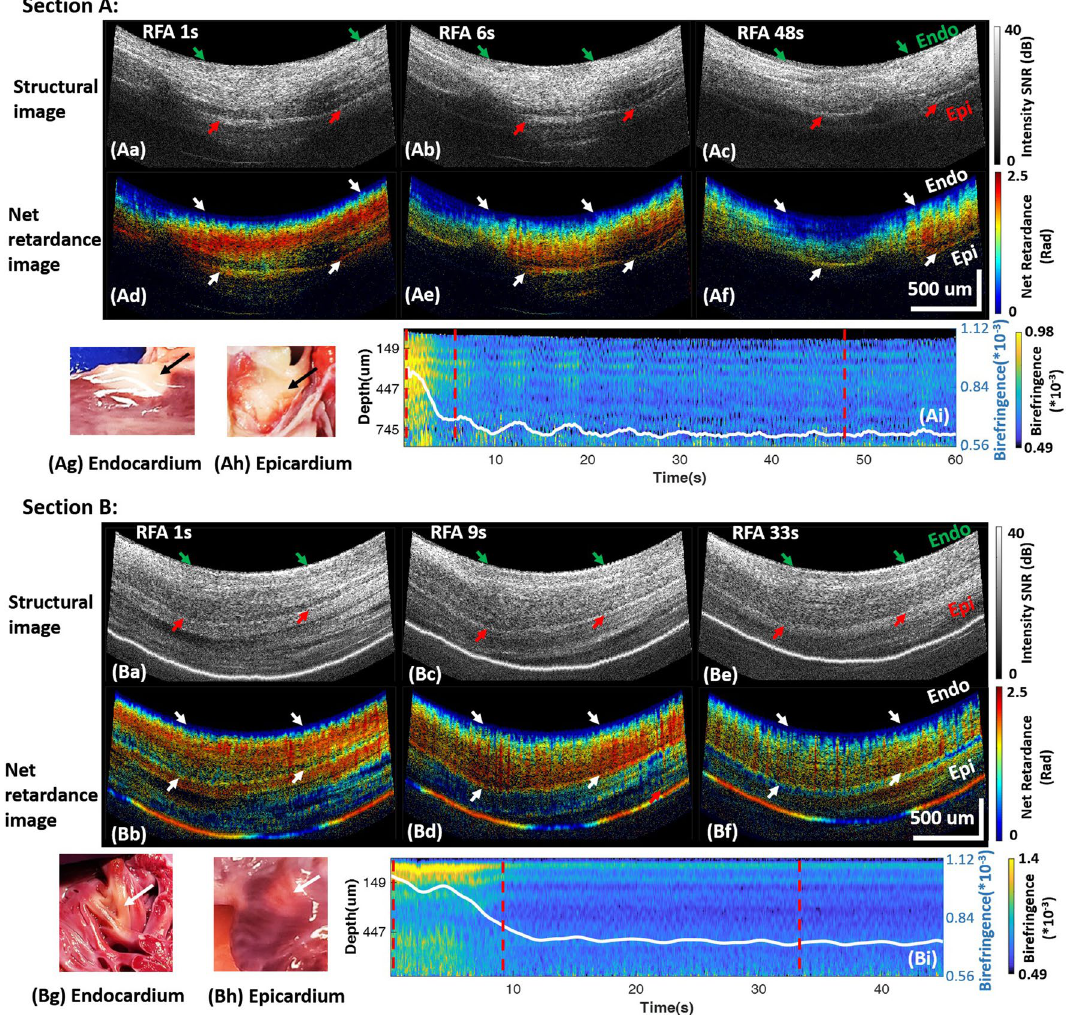
Figure 4. Transmural lesions at the LPV (Section A) and LAA (Section B). For both sections A and B, panels ( a – c ) and ( d – f ) are the structure images and net retardance images of the lesion at three time points during ablation, respectively; panels ( g , h ) are photos of the TTC stained lesion on the endocardium and epicardium; ( i ) shows the cross-A-line averaged tissue birefringence change and the averaged tissue birefringence change. Videos are provided as supplementary video v4 and